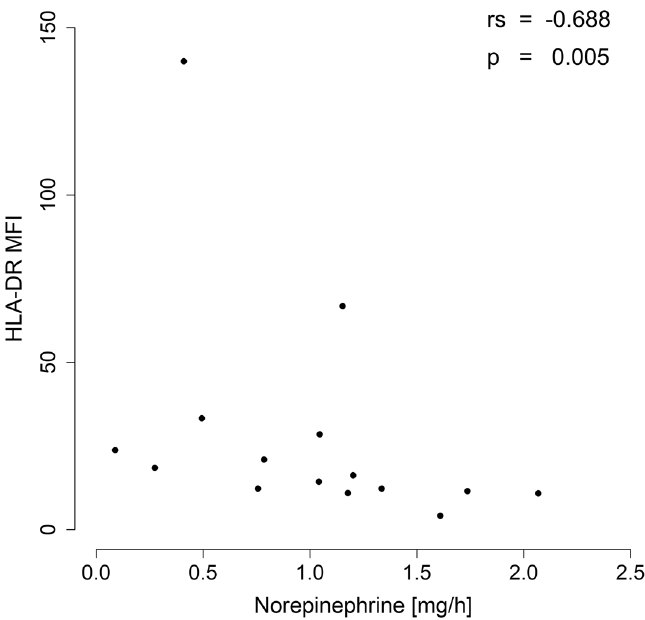
Figure 4. Correlation of monocyte HLA-DR surface expression and dosage of norepinephrine therapy. There was a statistically significant negative correlation between monocyte HLA-DR surface expression and dosage of norepinephrine [mg/h] to maintain a mean arterial blood pressure ≥ 80 mmHg after 48 h following cardiac arrest (CPR t3: r s = − 0.688; p =